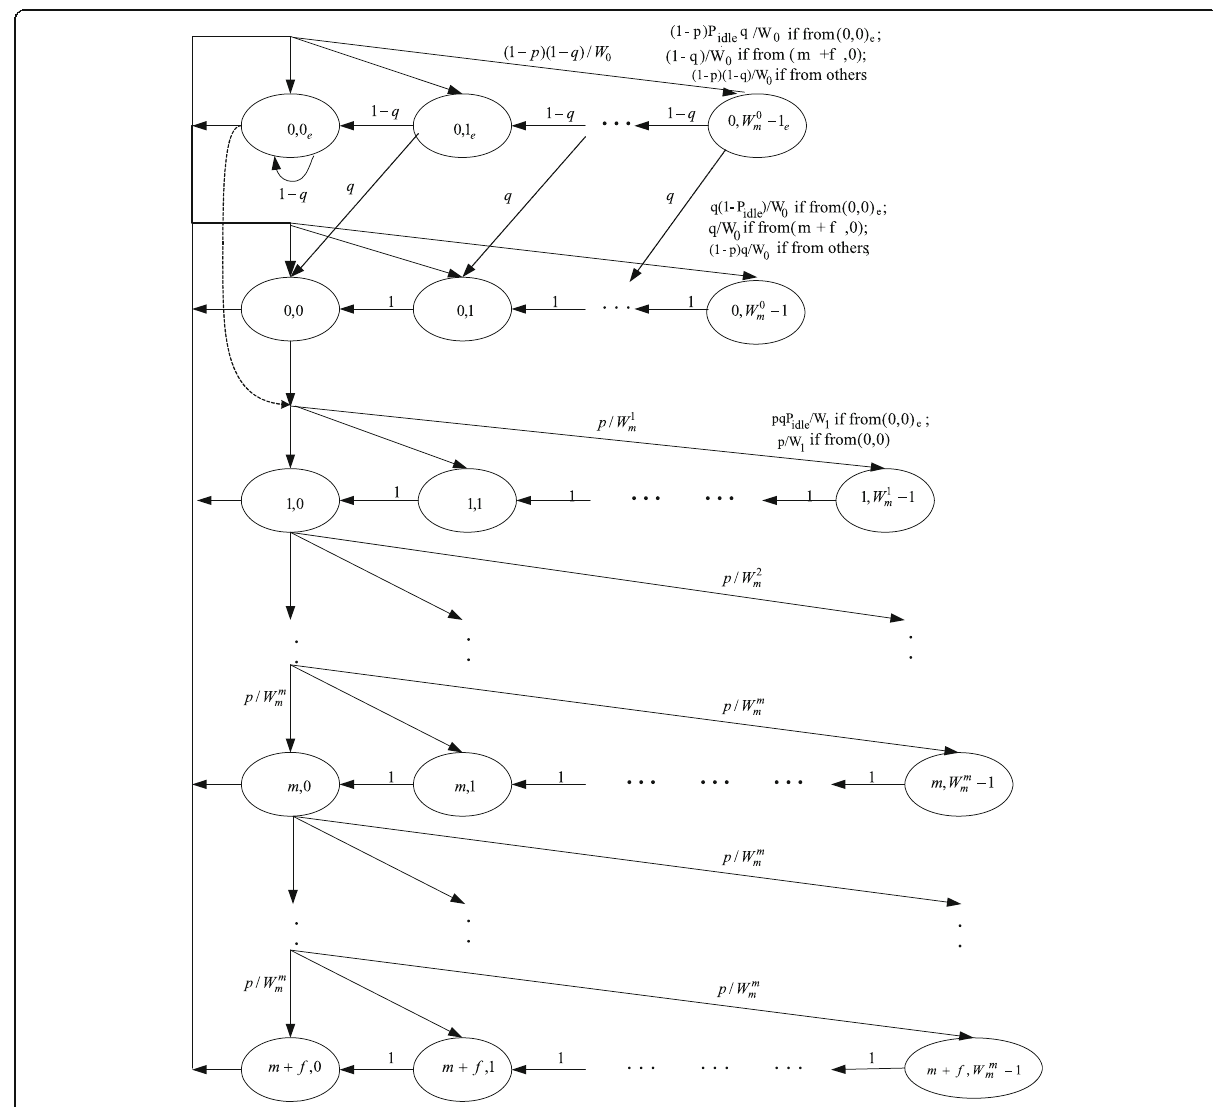
Fig. 2 Markov chain for the backoff